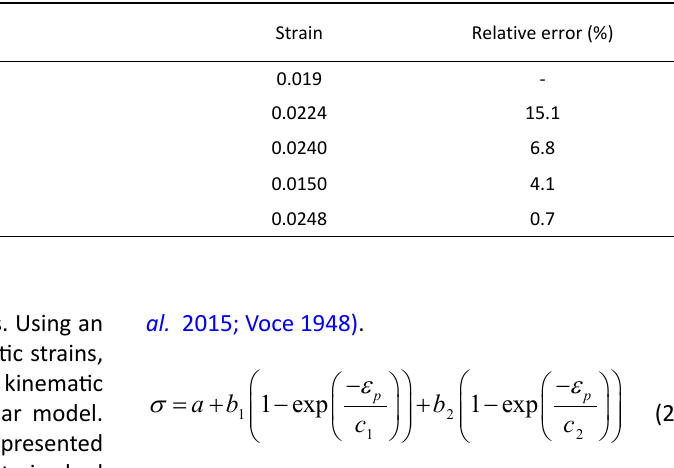
Maximum size of mesh sides (mm)